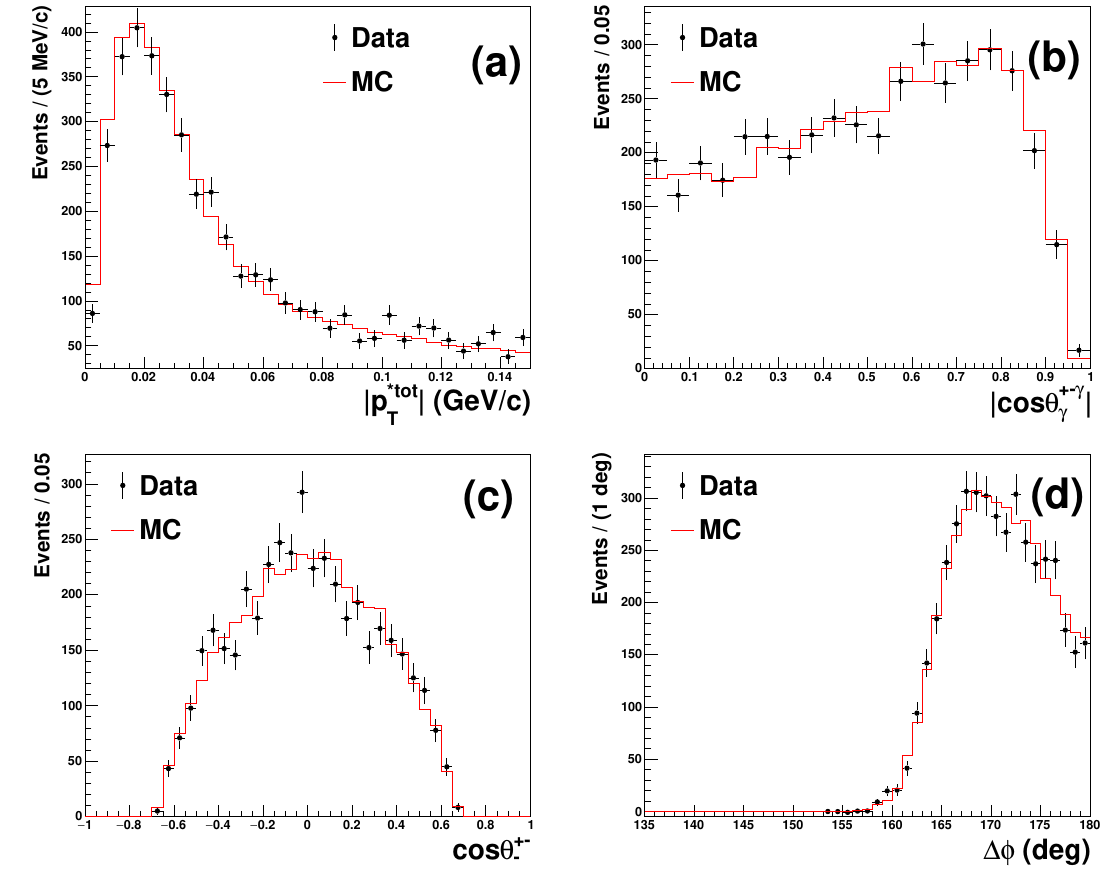
Figure 4 . Comparisons of the signal MC (red histogram) with the background sample subtracted data sample estimated from J/ψ sideband events combined with e + e − and µ + µ − pairs (black points with error bars) between ∆ M = 0.42 GeV/ c 2 and 0.49 GeV/ c 2 for (a) | p ∗ tot cos θ + − ; (d) ∆ φ . There are no entries in the ∆ φ < 135 ◦ . The signal MC is normalized to the − observed number of events in data